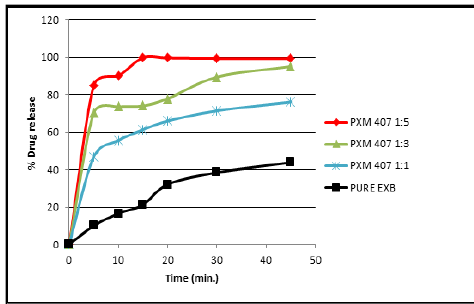
Figure 6. Effect of EXB: PXM 407 ratio on the per cent drug release profile from EXB- solid dispersion formulated by the solvent evaporation method in phosphate buffer pH 6.8 dissolution medium at 37°C.